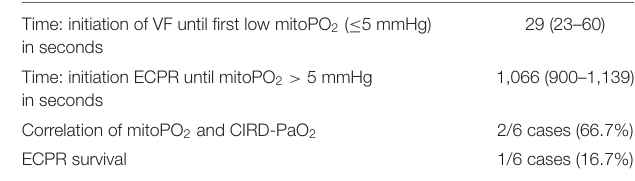
TABLE 2 | Summary of